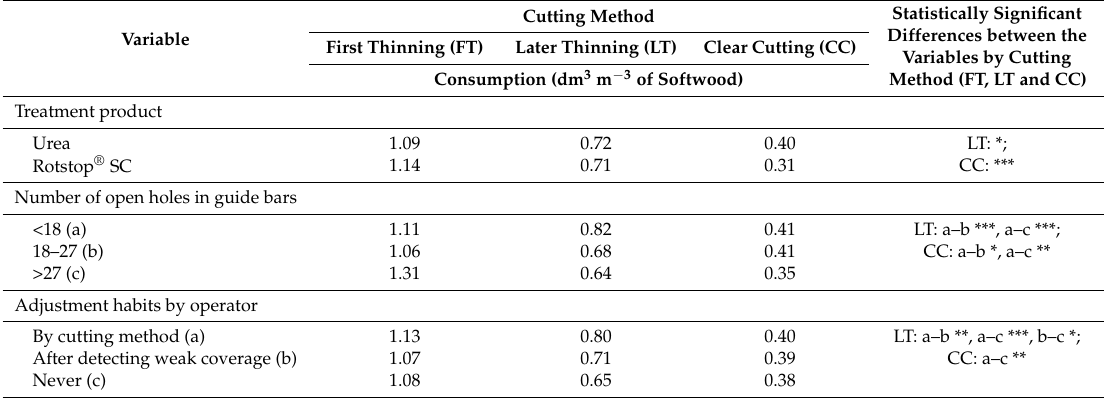
Table 3. The average consumption of stump treatment material by cutting method in the study.